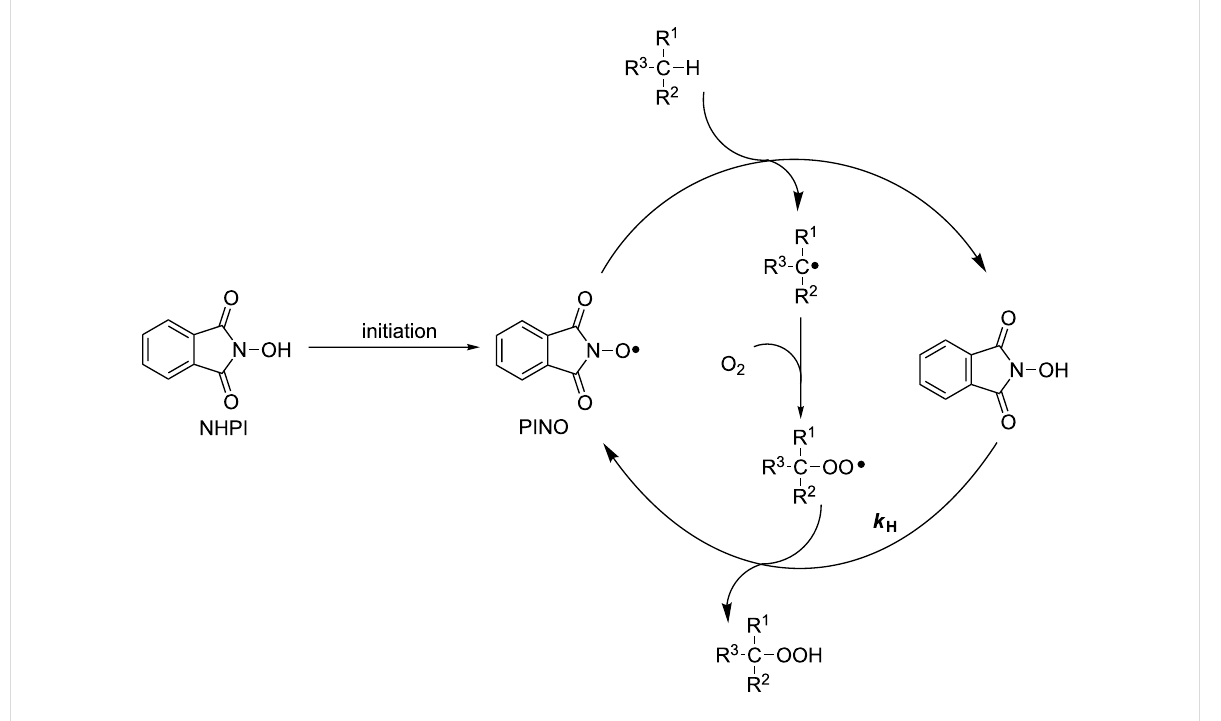
Scheme 1: Catalytic role of NHPI in the selective oxidation of organic